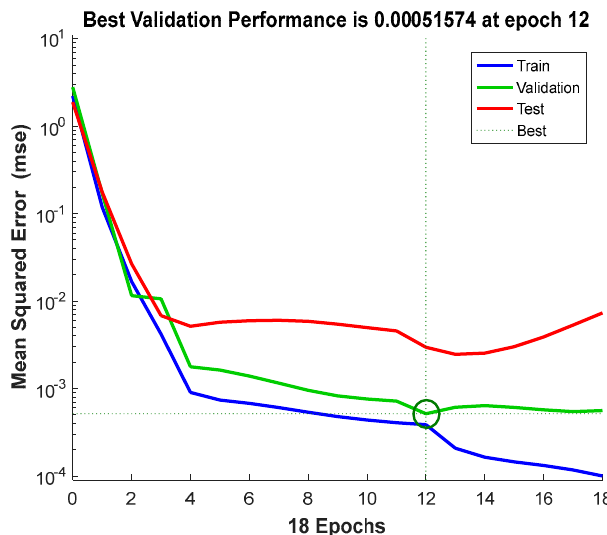
Figure 8. The neural network training performance (epoch 18, validation stop). Table 6. Optimum ANN parameters for the design of the model